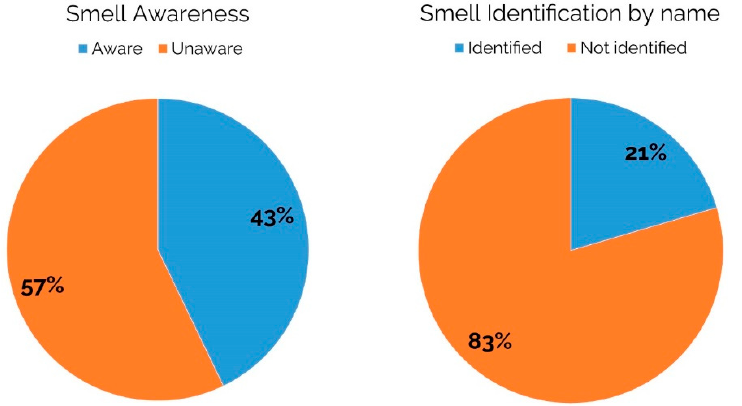
Figure 8. Mental Effort for the time segments associated respectively to the generic message (welcome message) and the informative message (slowdown message).